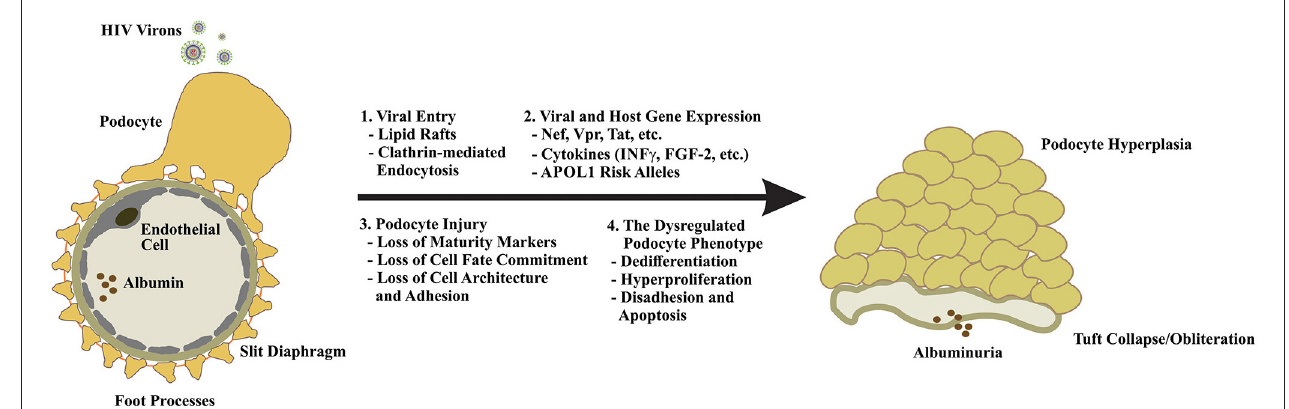
FIGURE 2 | Podocyte dysfunction in response to HIV infection is multifaceted. Because podocytes lack the receptors for canonical viral entry, viral particle entry via lipid rafts, and by clathrin-mediated endocytosis have been proposed (1). Upon entry, expression of viral genes and other mediators of innate immunity drive podocyte cytotoxicity and may enhance the expression of the high-risk APOL1 alleles in individuals of African descent to increase their risk of developing HIVAN (2). Podocyte injury manifests in the loss of maturity markers (e.g., nephrin, synaptopodin, WT1, CALLA, etc.), loss of cell fate commitment, and hyperplasia and the loss of cytoarchitecture and adhesion (3). The dysregulated podocyte phenotype appears to be irreversible and largely unresponsive to standard-of-care FSGS therapies highlighting the urgent need for a nuanced understanding of disease evolution, novel therapeutics, and early intervention